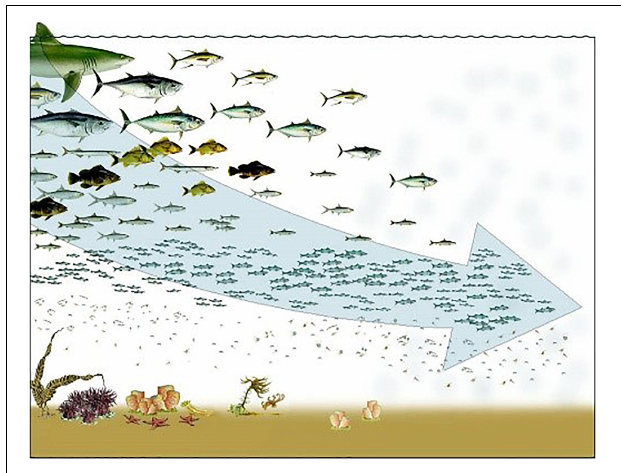
FIGURE 1 | Overfishing truncates the food web and simulates the same effects of “fishing down food webs.” Figure adopted from Pauly et al.